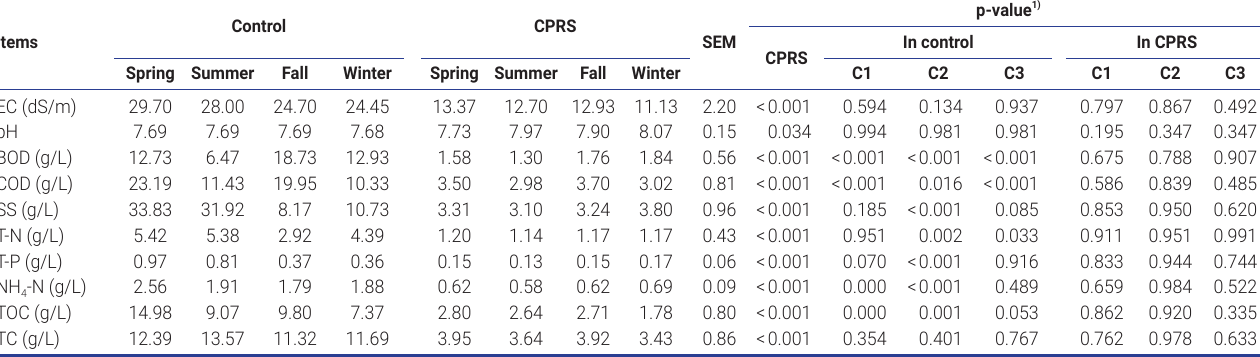
Table 3. Comparison of chemical properties of slurry of manure pit according to the application of a continuous pit recirculation system in the finish - ing pigsty (seasonal) Control CPRS Items